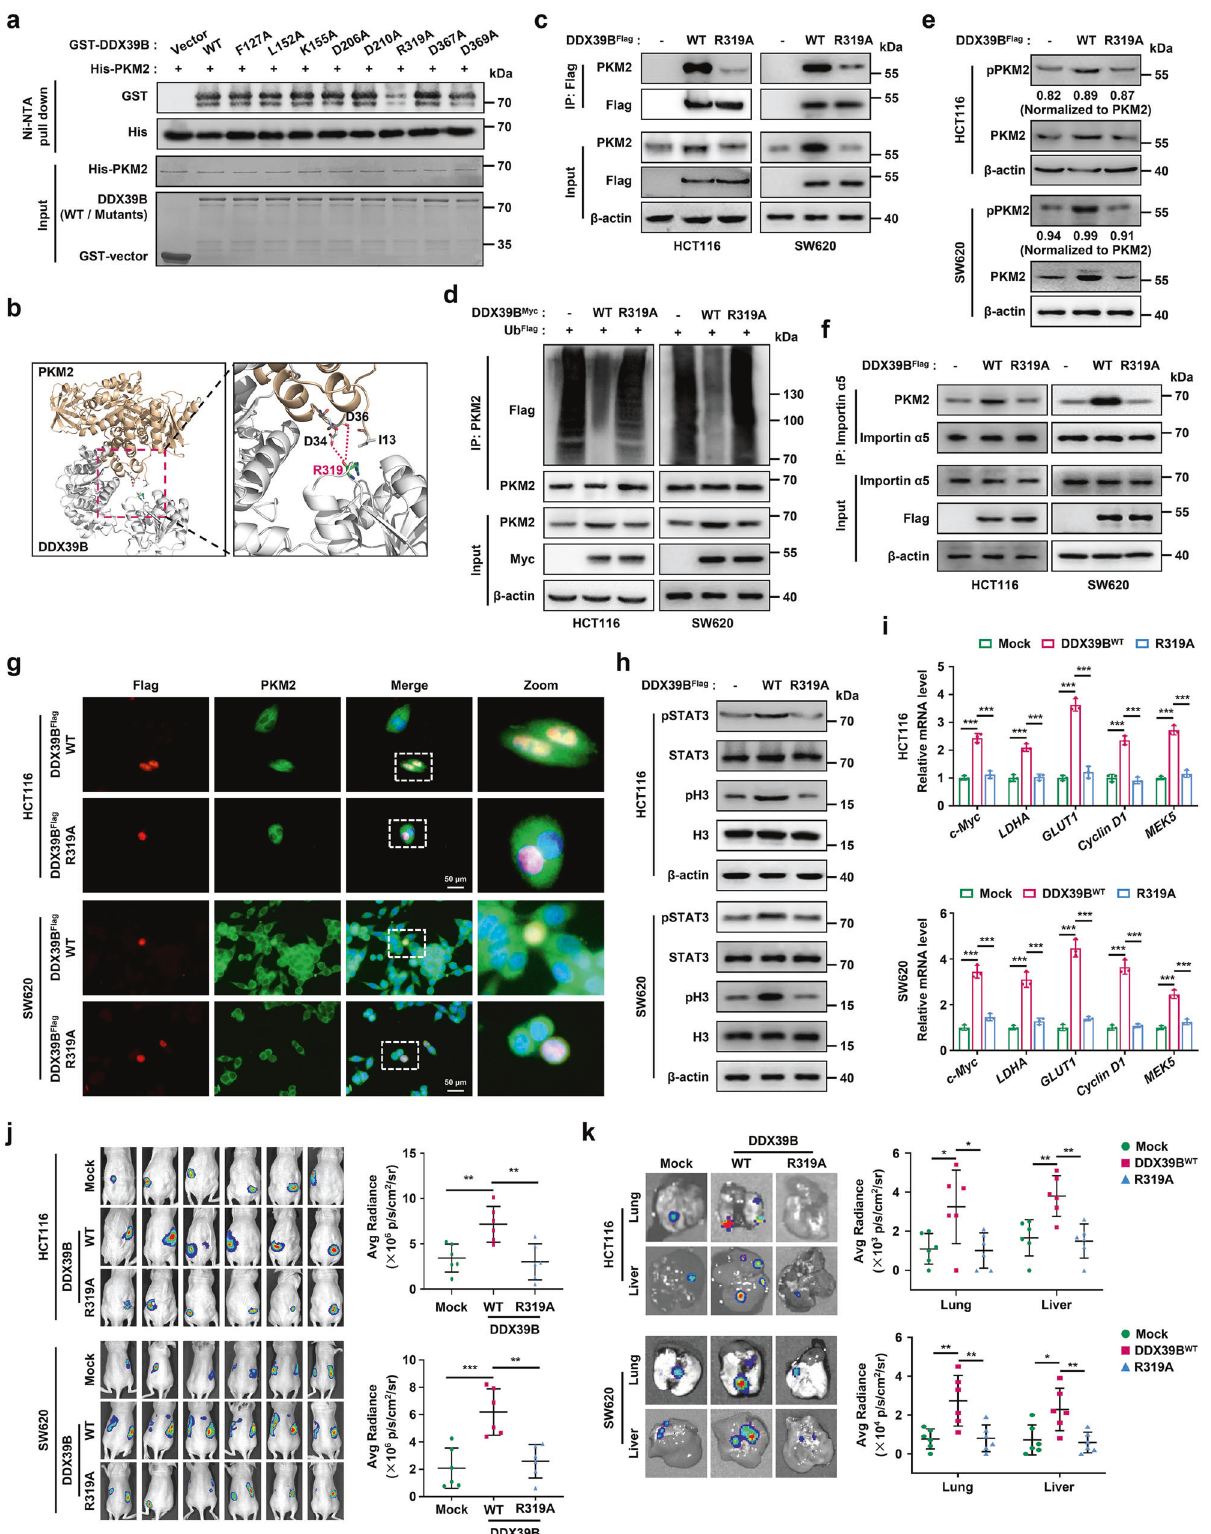
molecular dynamics simulation (Supplementary Fig. 9a). The binding free energy and the energy component for the DDX39B-PKM2 complex were calculated (Supplementary Table 4 (http:// and Supplementary Fig. 9b) and the eight amino acids of